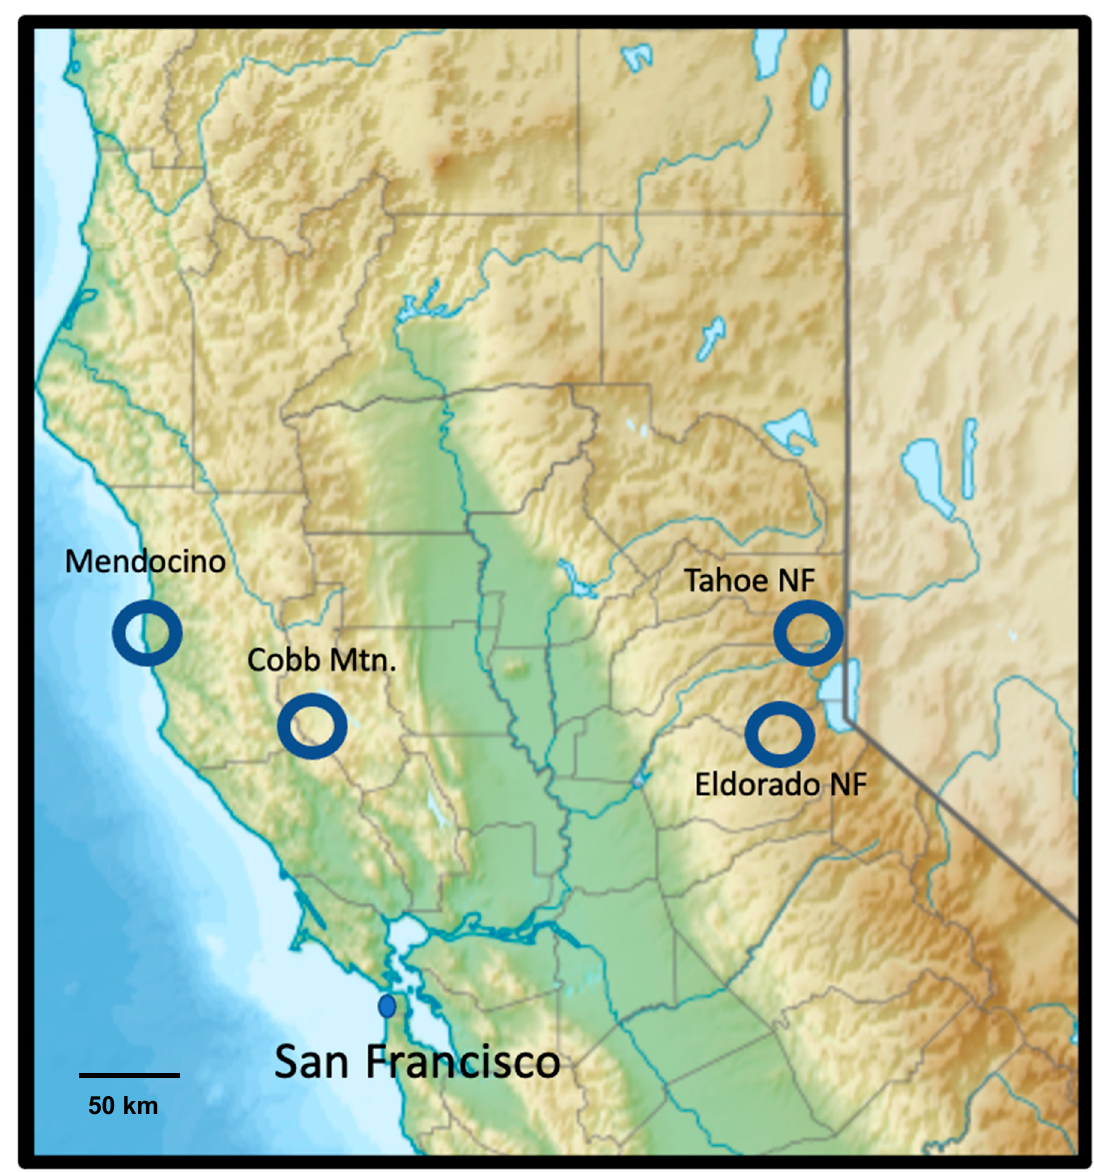
Figure 1. Map of the areas in California that were intensively surveyed for the presence of Phlebiopsis gigantea.